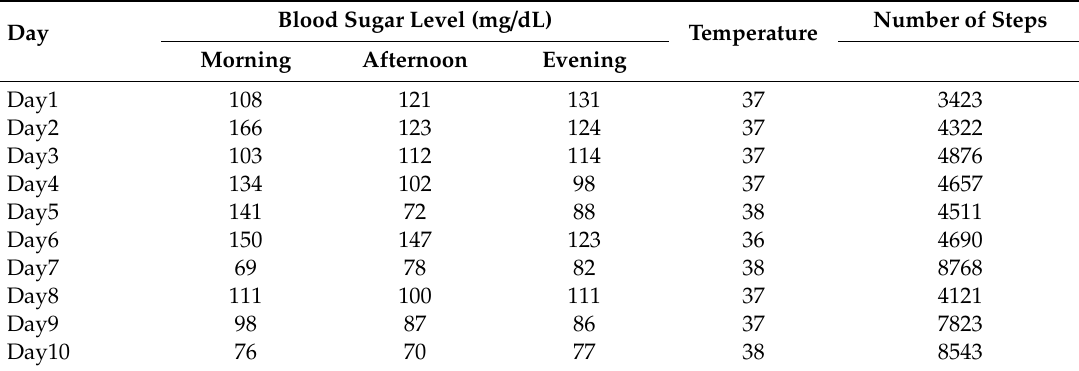
Table 2. Glucose, temperature and number of step measurement.